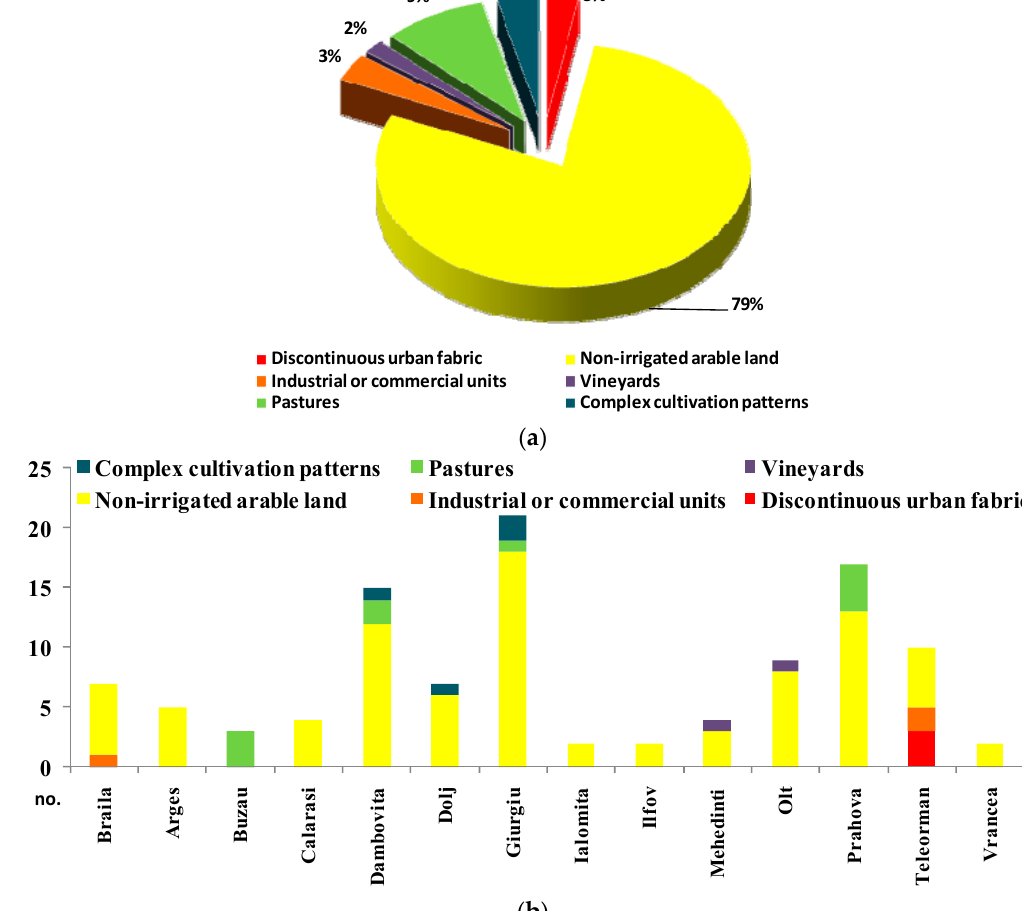
Figure 6. PV farm distribution for land use/cover categories in the Romanian Plain ( a ) and at the county level ( b ).